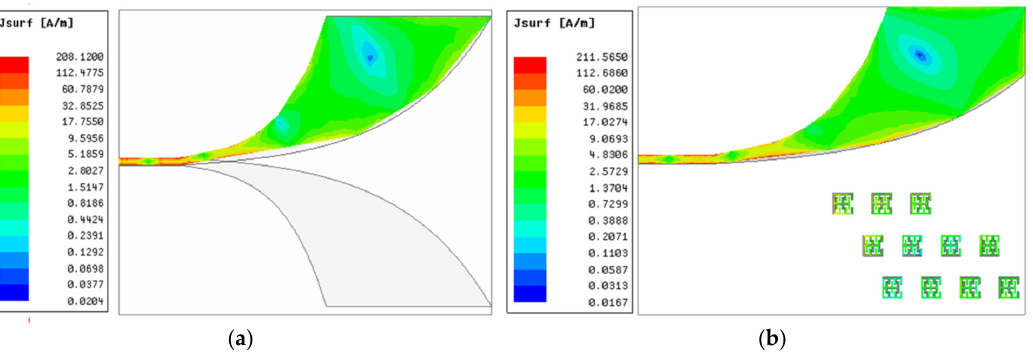
Figure 10. Surface current distribution in the Vivaldi antenna at 5 GHz ( a ) without and ( b ) with the metamaterial.